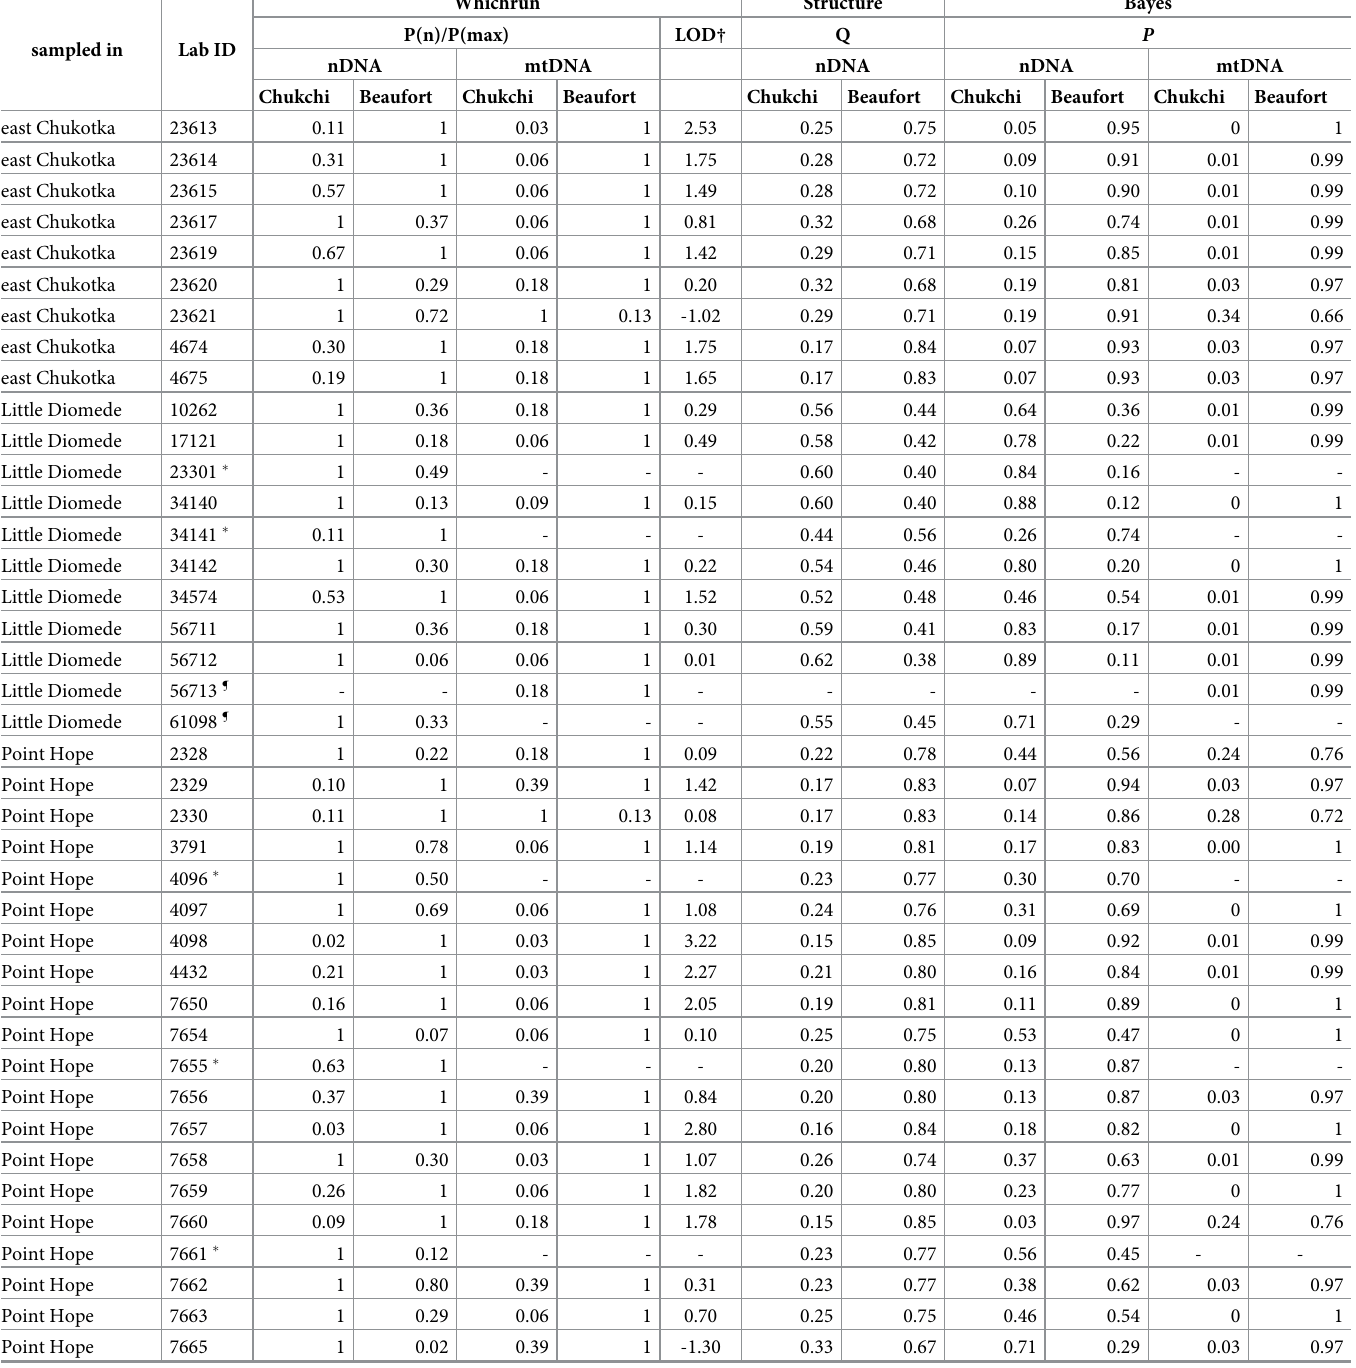
Table 4. The likely population of origin of beluga whales on spring migration sampled at four locations in the Bering, Chukchi and Beaufort Seas. Maximum likeli- hood assignments to two candidate populations, the eastern Chukchi Sea (Kasegaluk Lagoon) and the eastern Beaufort Sea (Mackenzie-Amundsen), were conducted in Whichrun and are reported both as likelihood ratios (P(n)/P(max)) and the Log of these ratios (LOD) for each individual. Bayesian assignments, using prior sample group information (i.e., LOCPRIOR models), were made using STRUCTURE and are reported as the estimated ancestry, Q, in Clusters 1 (Chukchi) and 2 (Beaufort). Assign- ments of individual migrants were also estimated using the stock-mixture method in BAYES, summarized here as the proportion of times, P , an individual was assigned to each baseline